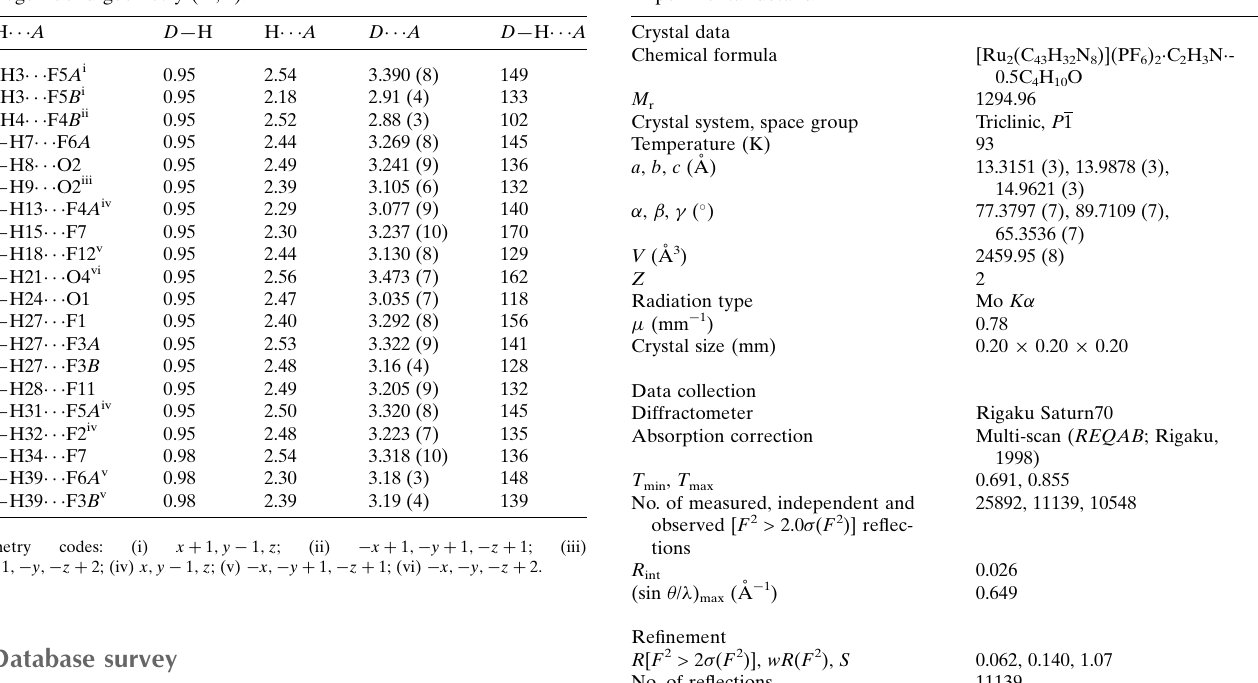
Table 2 Hydrogen-bond geometry (A˚ , (cid:4)